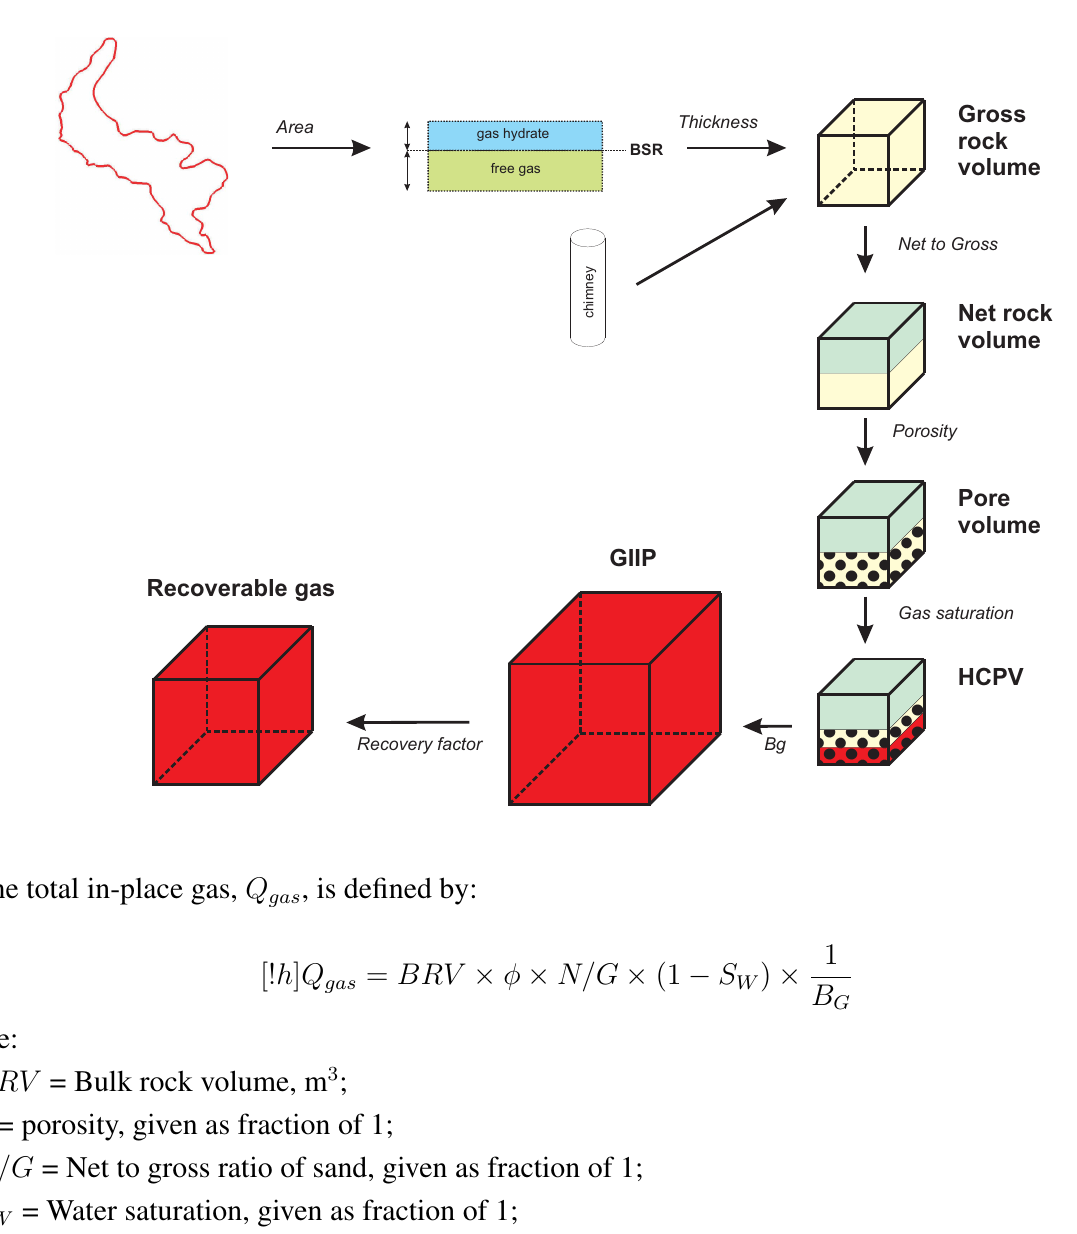
Figure 6. A sketch illustrating the Nyegga volumetric calculation. The three-dimensional reservoir extent is calculated based on the areal extent of the bottom-simulating reflection (BSR) and the thickness of the hydrate and free gas zones, based on ocean bottom seismometer (OBS) experiments. For the chimney zone, the gross rock volume (GRV) is directly defined by the study of Weibull [60]. Net-to-gross (NTG), porosity and gas hydrate saturation is applied to give a hydrocarbon pore volume (HCPV). Upon application of an expansion factor, B , a gas initially in place (GIIP) volume is calculated. Only a fraction G of the GIIP is technically producible, depending on the recovery factor, to give the final recoverable gas. Please note that GIIP equates in-place